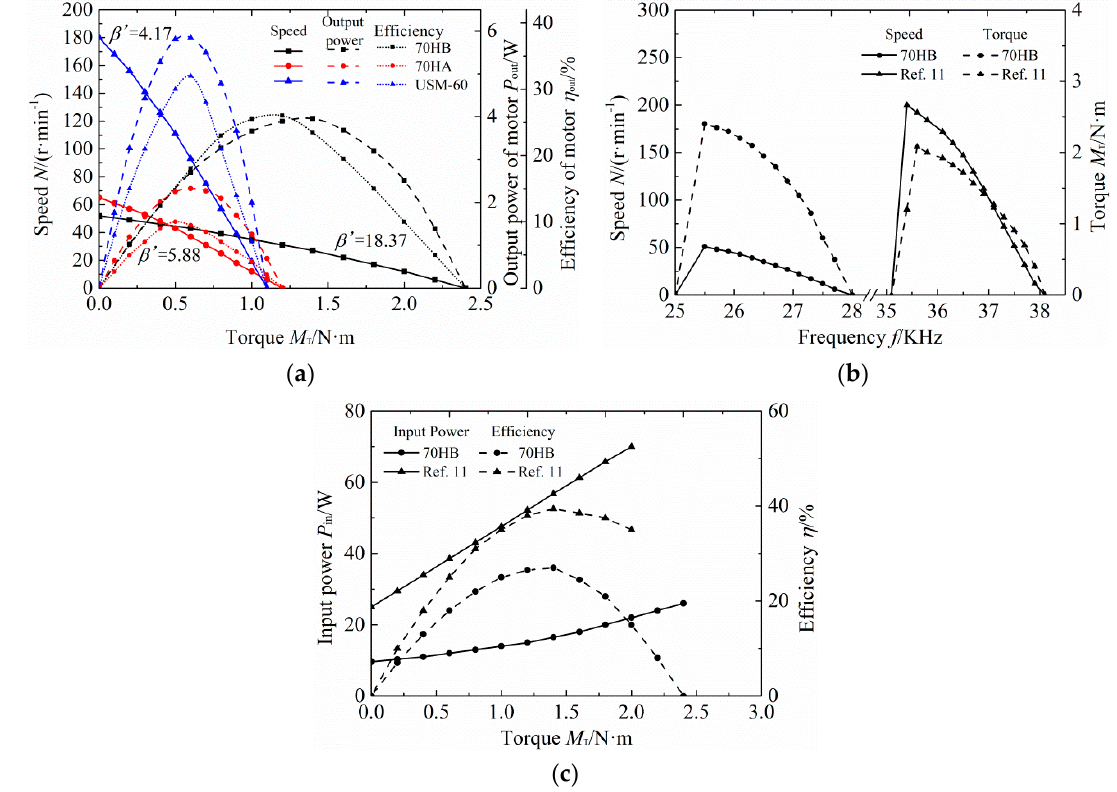
Figure 15. Performance curves of different motors: ( a ) mechanical characteristics of 70HA, 70HB, and USM-60; ( b ) mechanical characteristics of 70HB and the motor in Ref. [11]; and ( c ) power consumption of 70HB and the motor in Ref. [11]. Table 4. Results of maximum speed by simulation, calculation, and measurement.